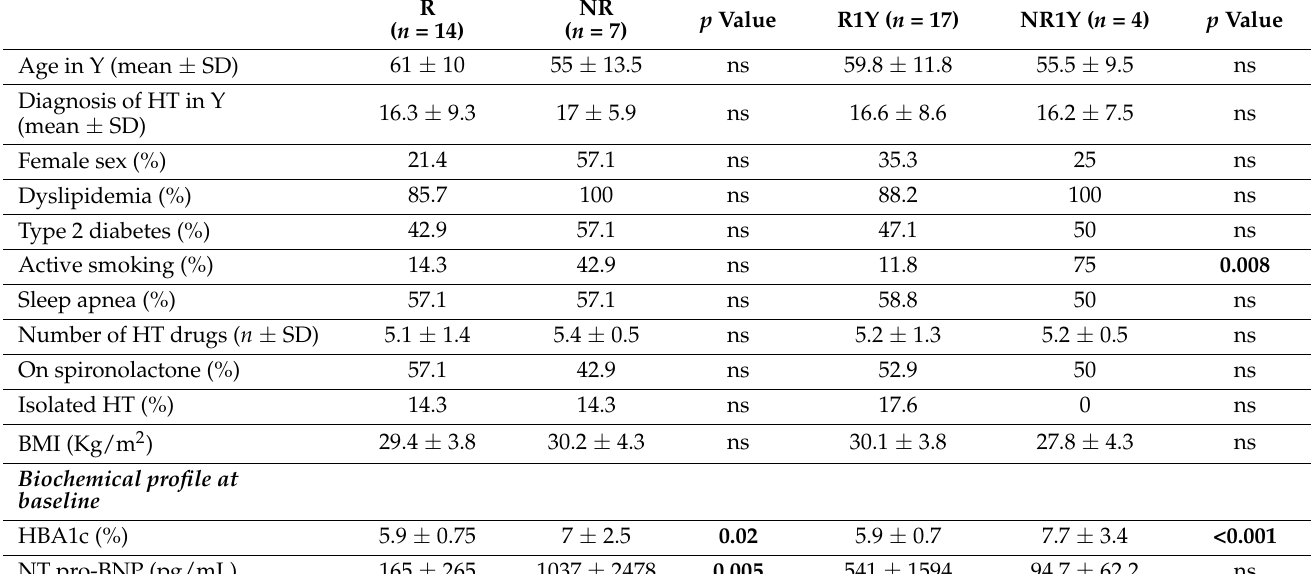
Table 1. Baseline clinical, biochemical and procedural characteristics. Ambulatory blood pressure monitoring behavior, from baseline to one year